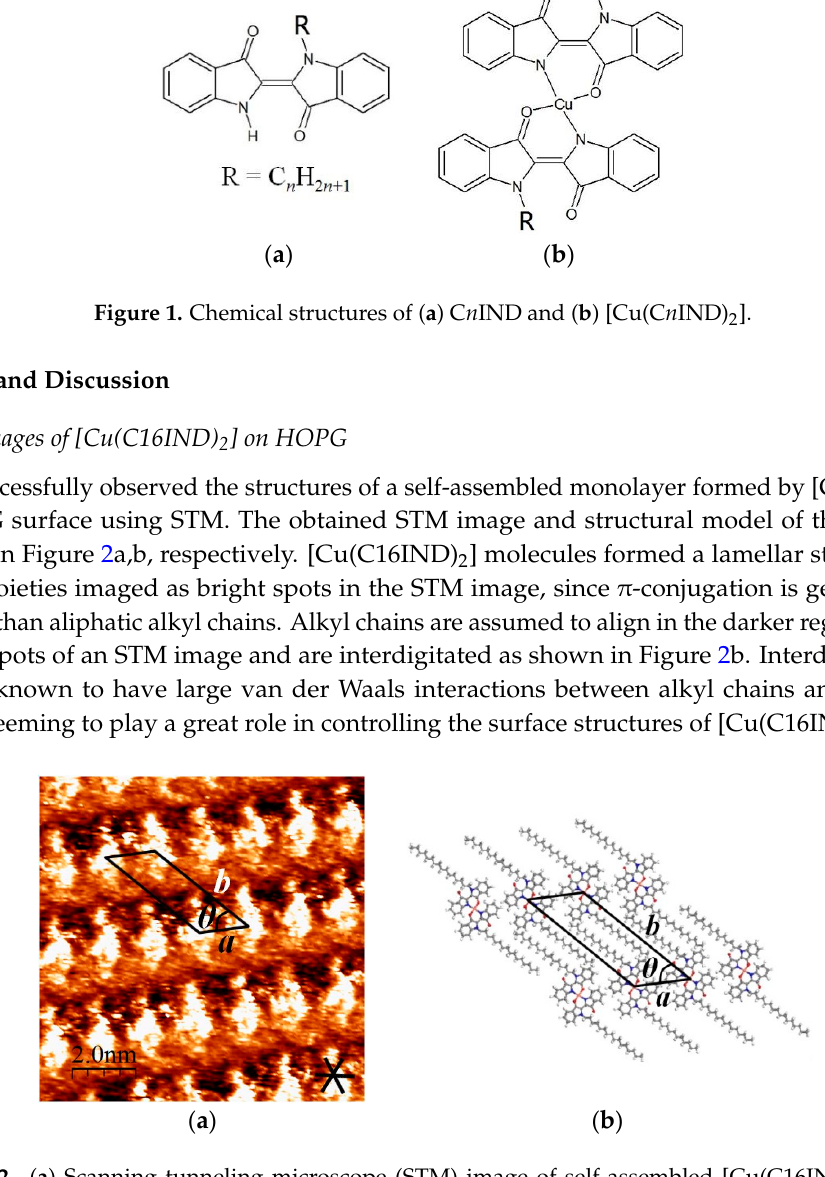
Figure 2. ( a ) Scanning tunneling microscope (STM) image of self-assembled [Cu(C16IND) 2 ] at a HOPG/o-dichlorobenzene interface. Image area: 10 × 10 nm 2 ; V set = 1.02 V, I set = 981 pA; ( b ) structural model for [Cu(C16IND) 2 ]; unit cell parameters: a = 1.5 nm, b = 3.6 nm, θ = 48°. The unit cell is taken so as to include the alkyl chains of a C16IND.